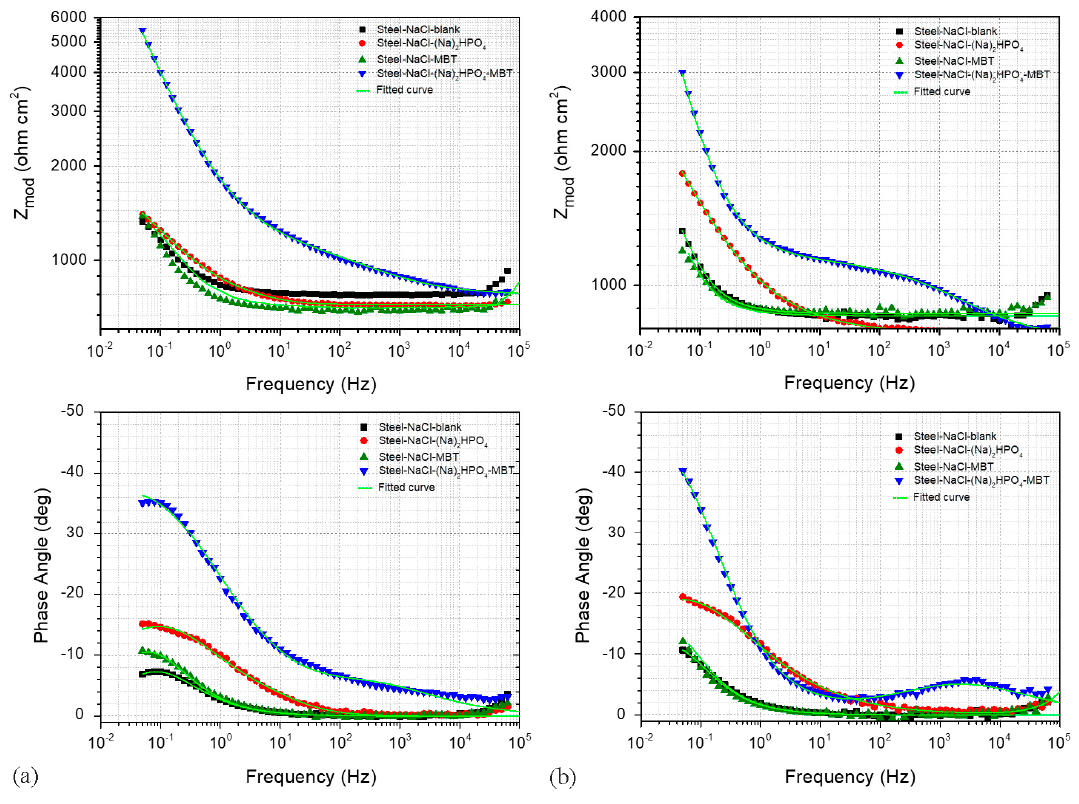
Figure 20. EIS plots recorded for mild steel panels after submission in 3.5 wt % NaCl for ( a ) 24 h and ( b ) 96 h: ( (cid:4) filled square ) Steel–NaCl–blank , ( (cid:8) filled circle ) Steel–NaCl–Na 2 HPO 4 , ( (cid:78) filled triangleD ) ( b ) 96 h: (  filled square ) Steel–NaCl–blank , (  filled circle ) Steel–NaCl–Na 2 HPO 4 , (  filled Steel–NaCl–MBT , ( (cid:72) filled triangleU ) Steel–NaCl–Na 2 HPO 4 –MBT , ( – ) Fitted triangleD ) Steel–NaCl–MBT , ( ▼ filled triangleU ) Steel–NaCl–Na 2 HPO 4 –MBT , ( -- ) Fitted curve.